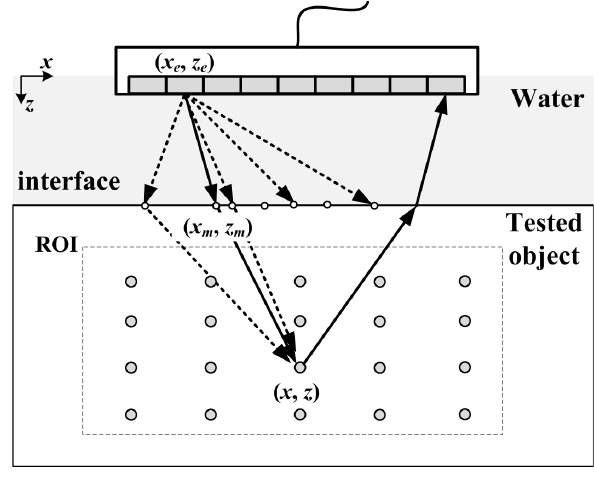
Figure 1. ROI of water-object material.